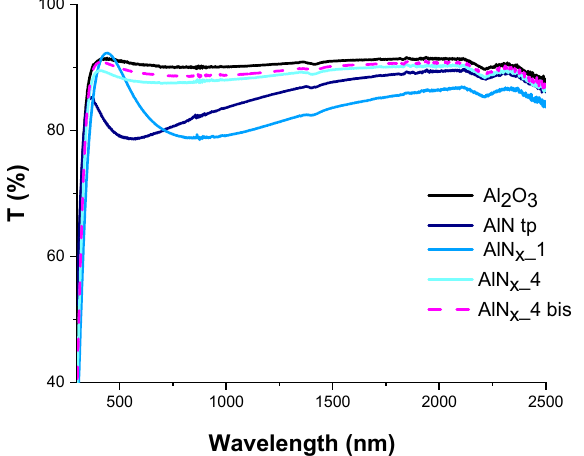
Table 3. WCA of oxygen-doped aluminum nitride thin films.